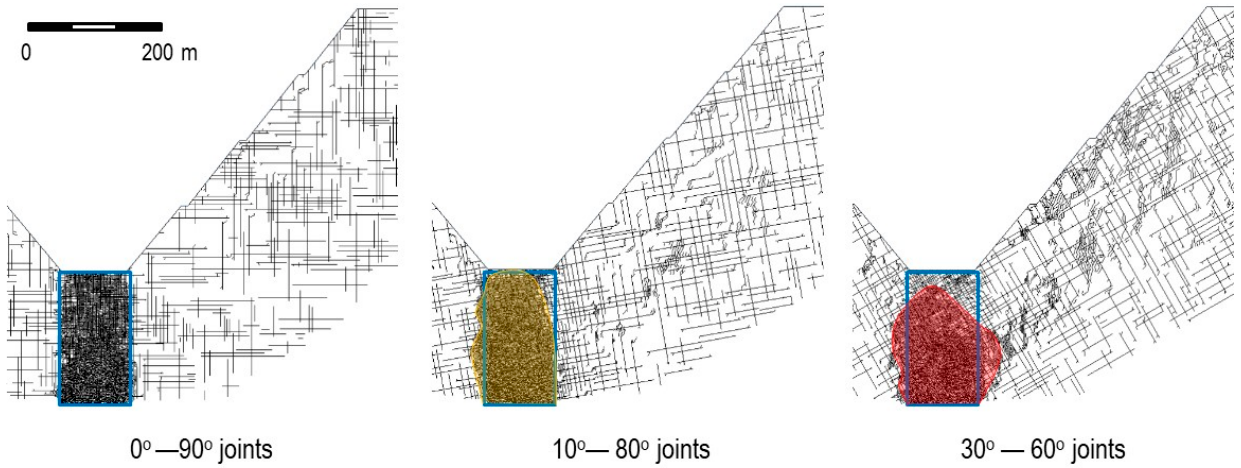
Figure 4. Effect of joint orientation (models with 0 ◦ –90 ◦ ; 10 ◦ –80 ◦ ; and 30 ◦ –60 ◦ ) on cave development and slope behavior.